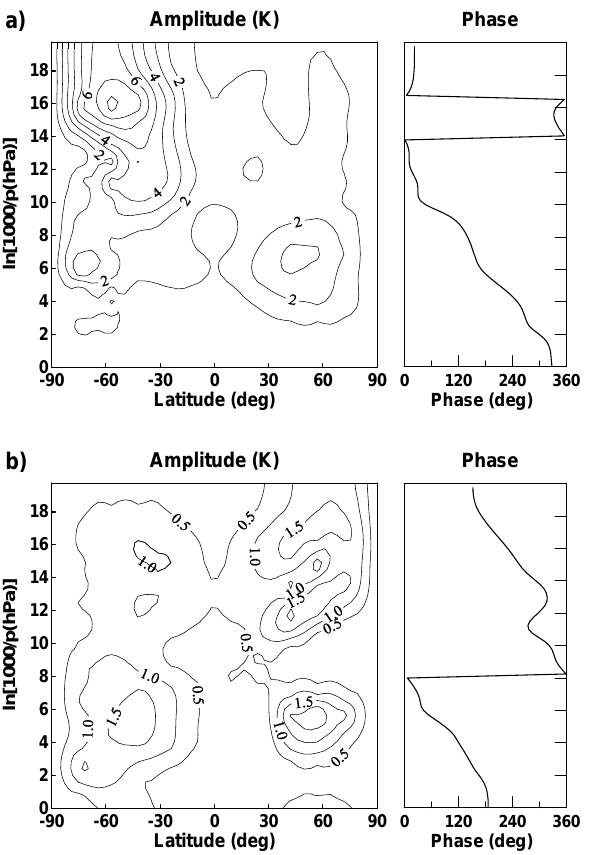
Fig. 7. As in Fig. 4, but for the 16-day wave. The phases are shown at 45 ◦ N ( a ) and 45 ◦ S ( b ) .